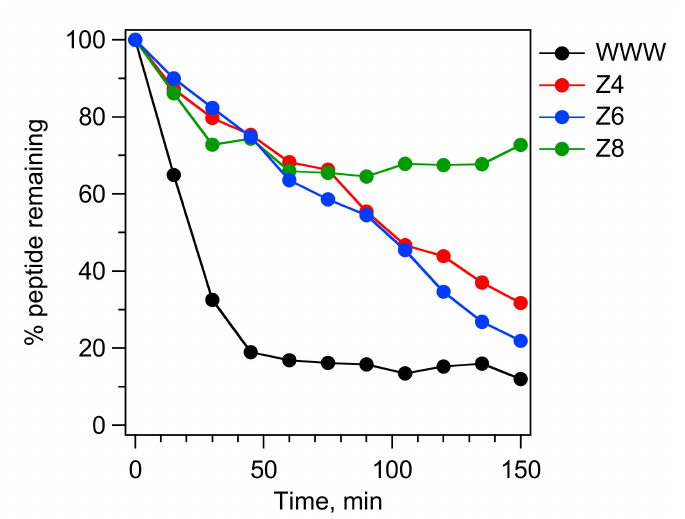
Figure 5. Presence of AzAla in the sequence makes peptides less susceptible to proteolytic degrada- tion. Absorbance of original peptide mixed in a solution with the protease trypsin was monitored over time using analytical